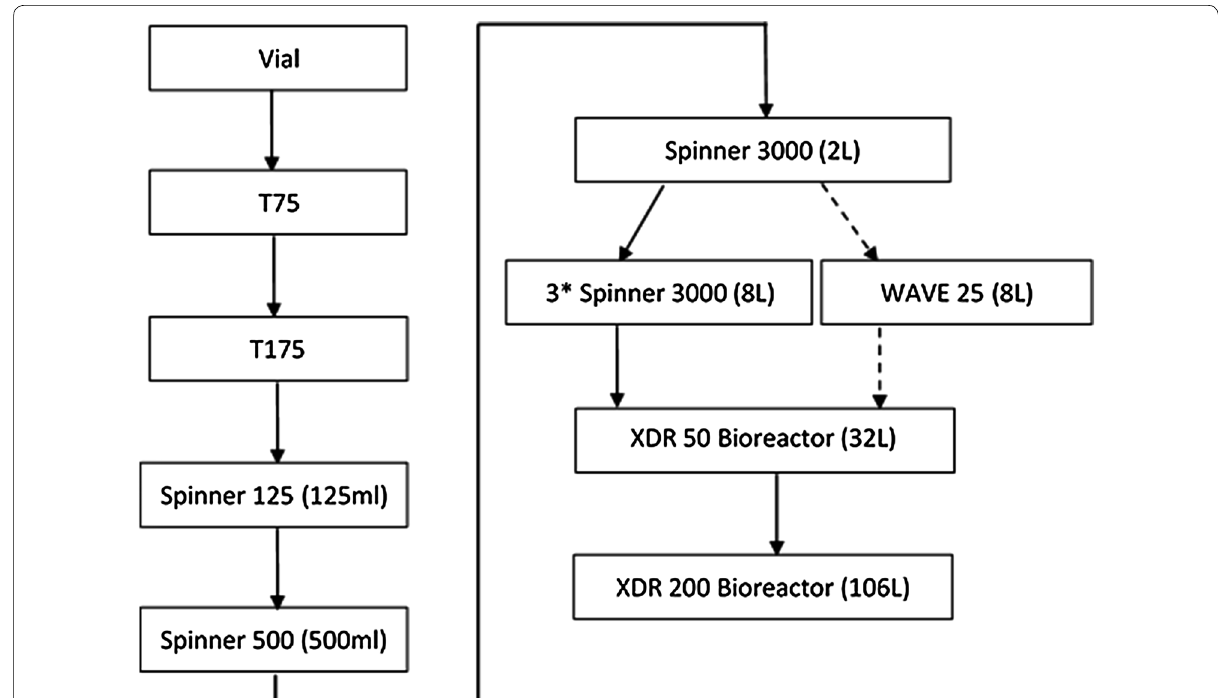
Fig. 1 Expansion flow chart of HEK293T cells and Vero cells. The dotted arrow represented an option to large-volume seed